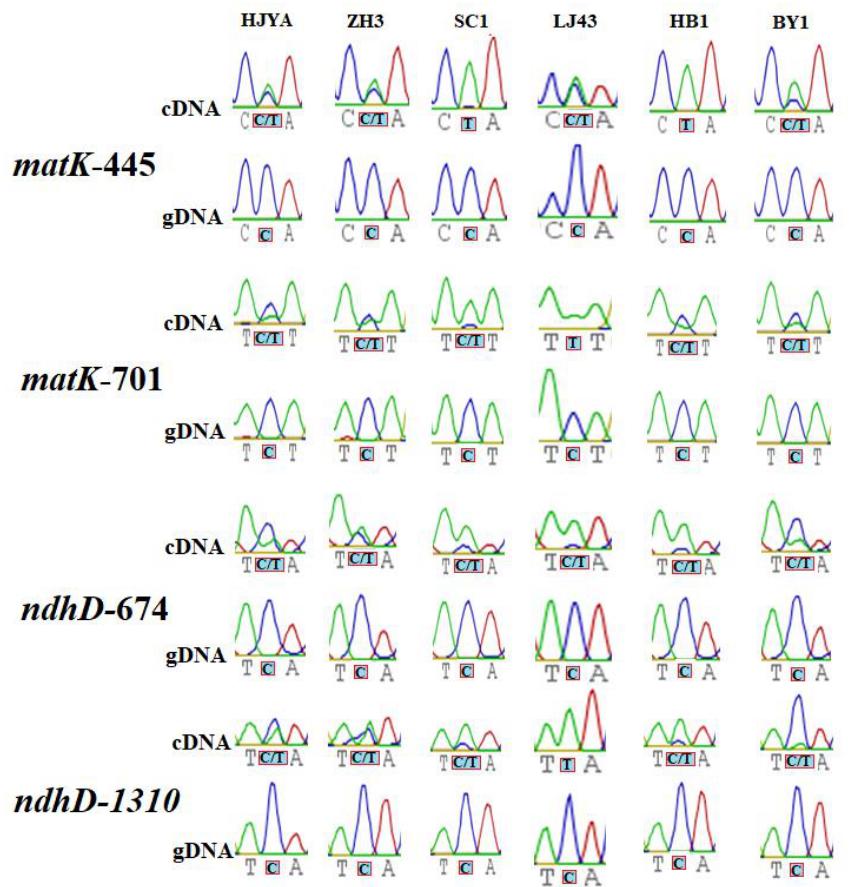
Figure 5. Editing levels of 4 RNA editing events in 6 varieties (LJ43 and SC1 with normal green leaves, HJYA and ZH3 with etiolation leaves and HB1 and BY1 with albino leaves) of tea plants. HJYA represents C. sinensis cv. ‘Huangjinya’ ; ZH3 represents C. sinensis cv. ‘Zhonghuang 3’ ; SC1 represents C. sinensis cv. ‘Shaancha 1’ ; LJ43 represents C. sinensis cv. ‘Longjing 43’ ; HB1 represents C. sinensis cv. ‘Huabai 1’ ; BY1 represents C. sinensis cv. ‘Baiye 1’ . The matk-445 represents 445 position of matK . The matk-701 represents 701 position of matK . The ndhD-674 represents 674 position of ndhD . The ndhD-1310 represents 1310 position of ndhD . Red boxes indicate the RNA editing sites in the gDNA and cDNA.